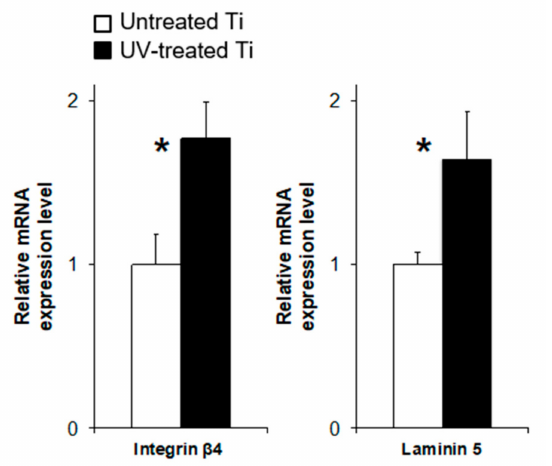
Figure 5. The mRNA expression of hemidesmosome-related proteins, integrin β 4 and laminin-5, after 12 h of culture. Relative mRNA expression levels were determined by using the delta–delta CT method with GAPDH as an internal control (* p <